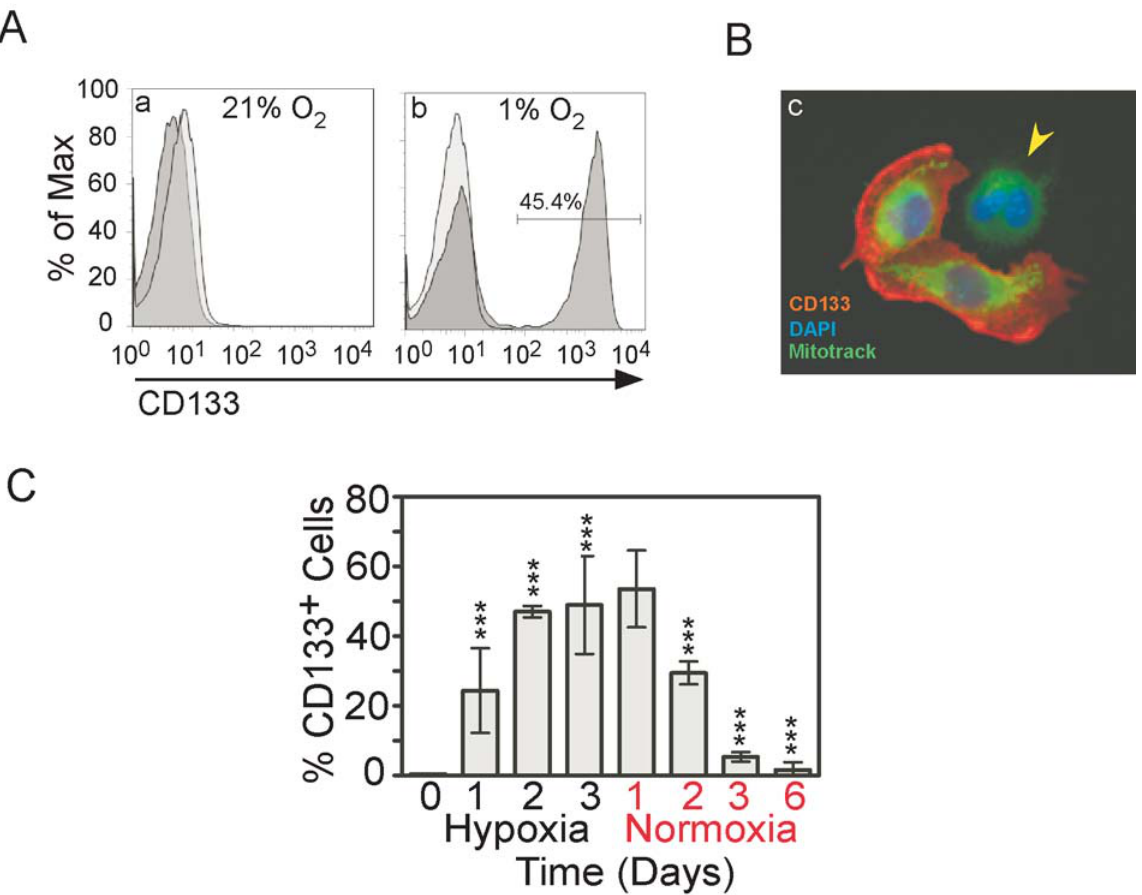
Figure 1. Expression of CD133 in U251 glioma cells under hypoxia. A) Flow cytometry histogram of representative U251 cells, with the first peak representing cells negative for CD133-phycoerythrin expression, and the second peak representing CD133 positive cells. Histogram of U251 in 21% oxygen ( a ) compared with 1% oxygen (b) . Data are representative of five similar experiments. B) Immunofluorescence photographs of representative U251 cells grown in 1% oxygen and processed with CD133 antibody (red). Cytoplasm and nucleus were stained with (1 m M) MitoTracker H (green) and DAPI (blue) respectively. Arrowhead showing one CD133-negative cell in the field. C) Time-dependent expression of CD133 in glioma cells under hypoxia and reoxygenation. Results are given as means 6 SD of 5 separate experiments. *** represent p , 0.001.